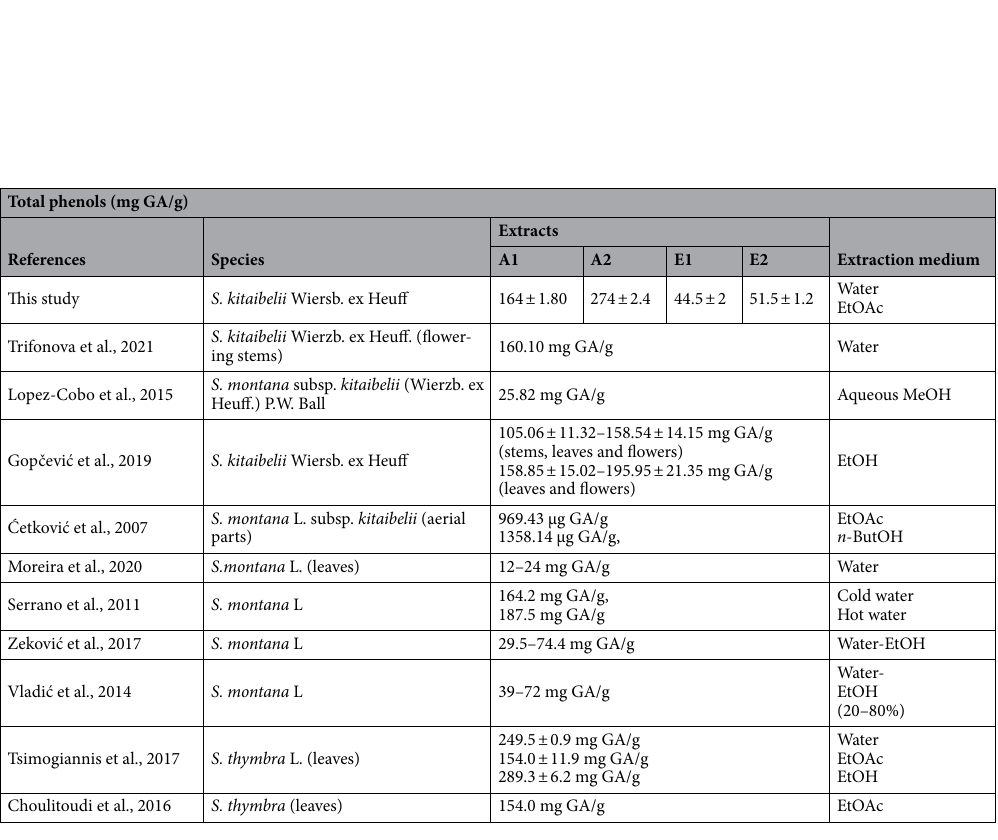
Table 2. Total phenols contents of aqueous and ethyl acetate extracts of stems, leaves and flowers (A1 and E1, respectively) and leaves and flowers (A2 and E2, respectively) of S. kitaibelii and comparison with relevant studies. EtOH ethanol, MeOH methanol, EtOAc ethyl acetate; Polarity index: Water − 1; Methanol − 0.762; Ethanol − 0.654, Ethyl Acetate − 0.440. The TPC has been determined in aqueous and ethyl acetate extracts of S. kitaibelii in this work for the first time. The highest content of total phenols was observed in the A2 extract (274 mg GA/g). The TPC was higher in both aqueous extracts (164 and 274 mg GA/g), compared to the TPC of both ethyl acetate extracts (44.5 and 51.5 mg